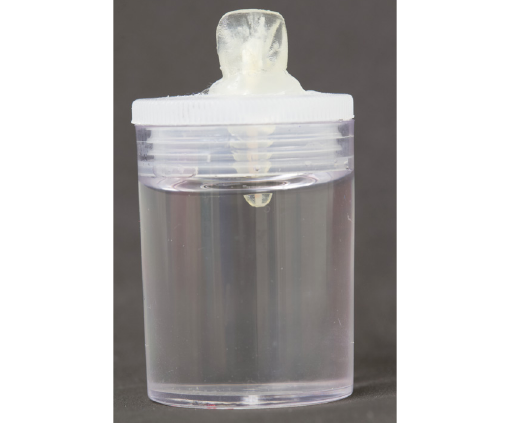
Figure 1. Filled root canal of a prototype with root apex in constant contact with Table 1. Median and standard deviation of flow (mm) and